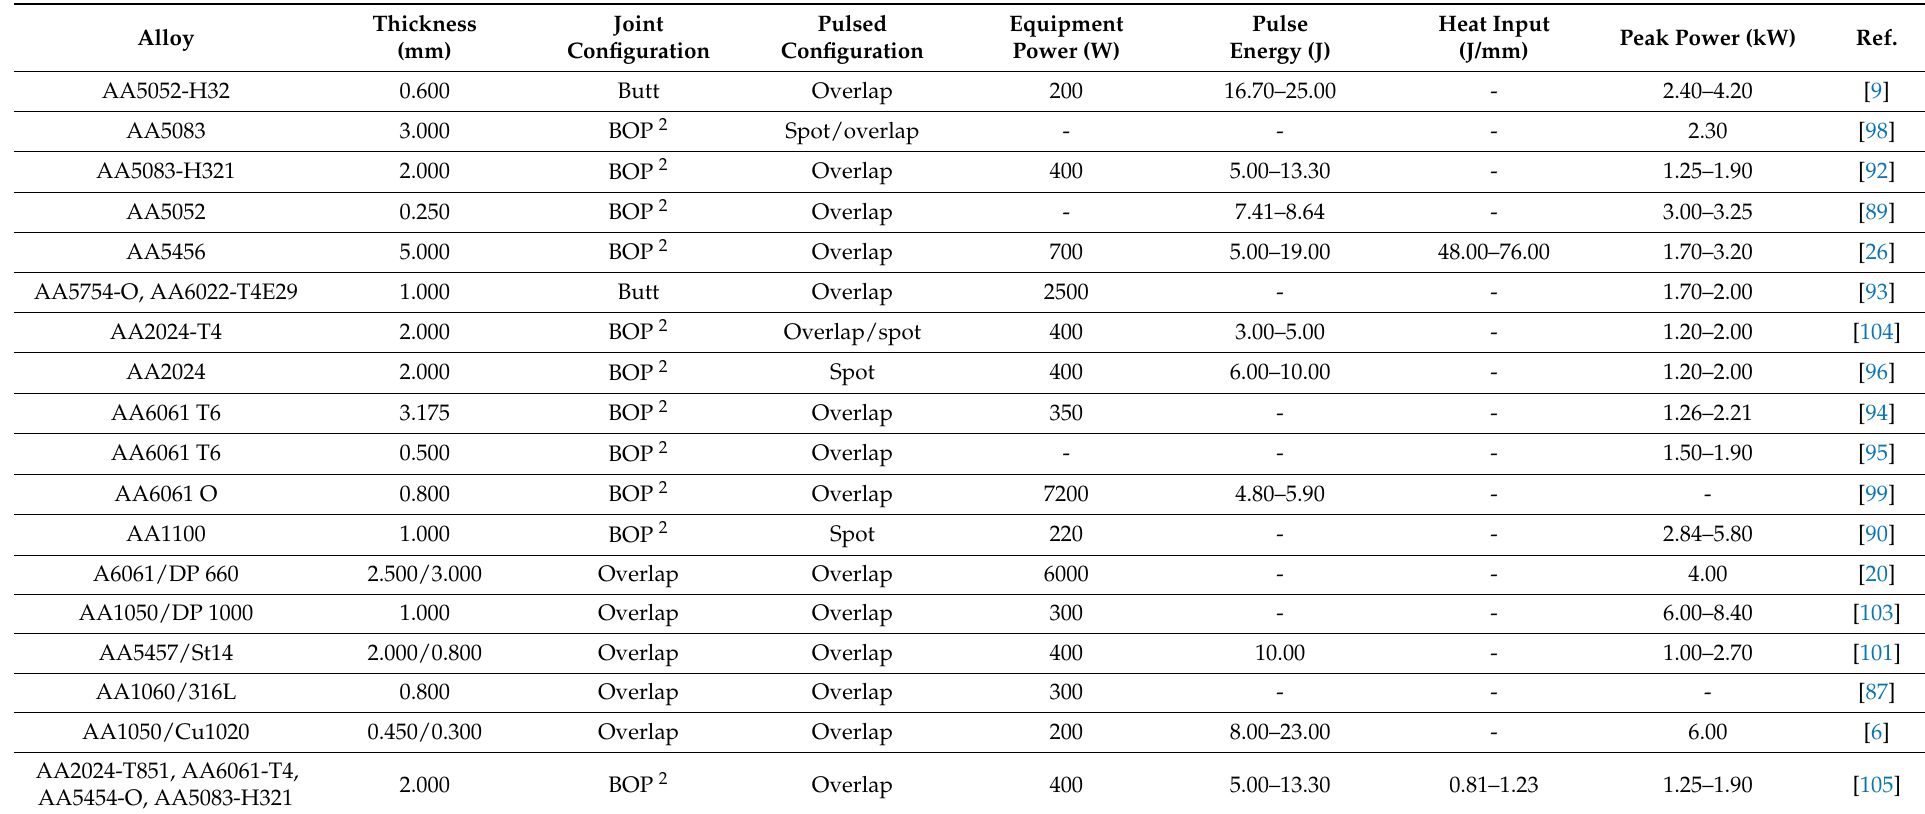
Table 8. Details of welding conditions applied to similar and dissimilar aluminium pulsed laser 1